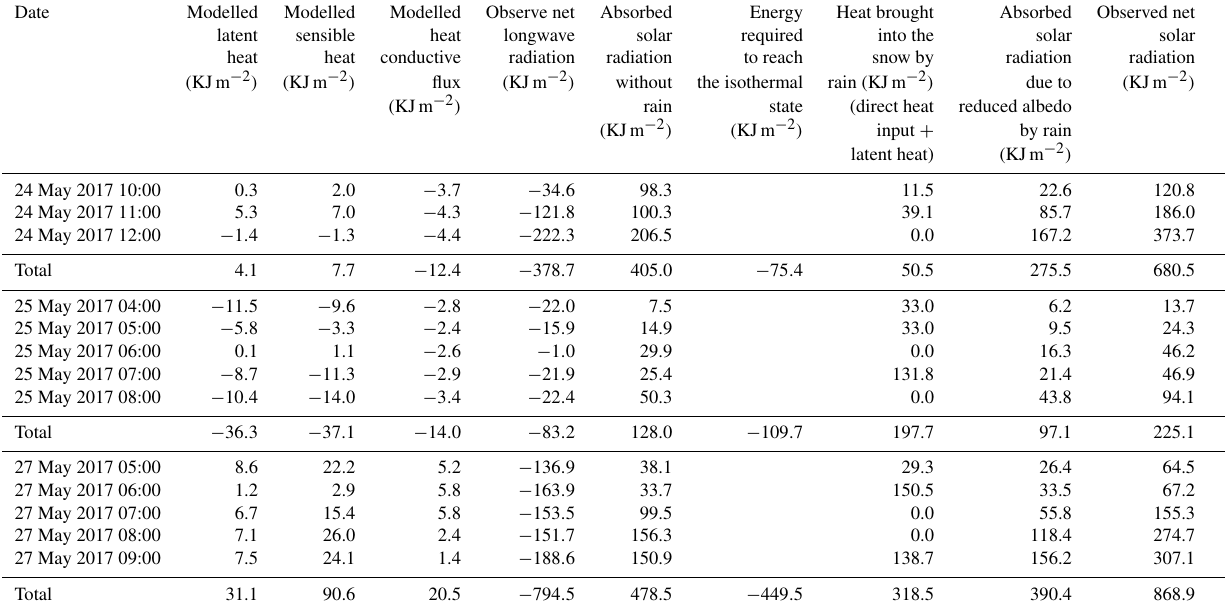
Table 2. Components of the surface energy budget, required for the snowpack to reach the isothermal state (warming phase). Date Modelled Modelled Modelled Observe